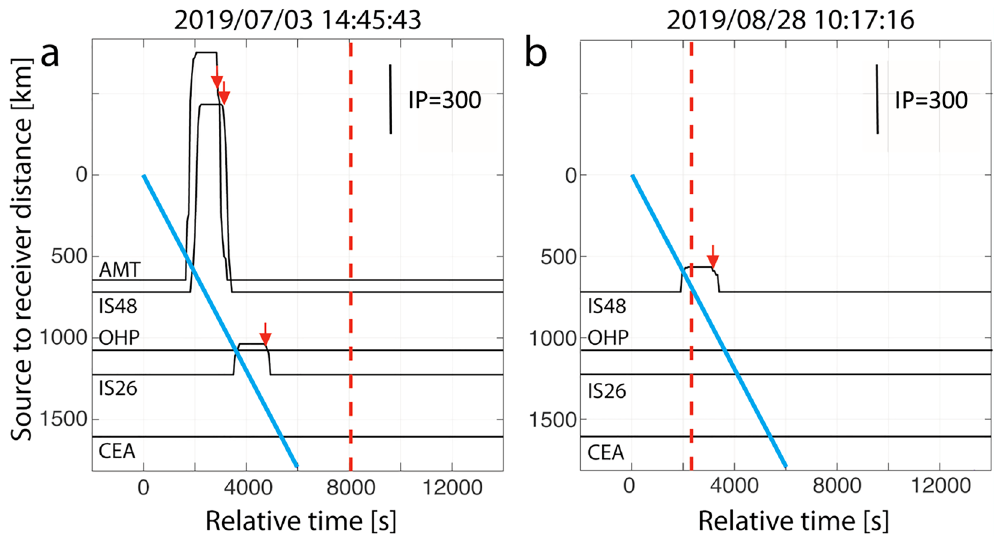
Figure 7. IP derived from infrasound detections at several stations for the July 3rd ( a ) and August 28th, 2019 ( b ) paroxysms at Stromboli. The vertical red line identifies the time of issuance of the VAA from Toulouse VAAC, while the pink line indicates the 300 m/s travel-time typical of stratospheric arrivals. The onset time of increased volcanic activity, based on the IP values exceeding the threshold of 60 for at least 20 min at each array, is shown by the red arrows. Such notification would have been possible at AMT, IS48 and IS26 for the July event, and at IS48 for the August